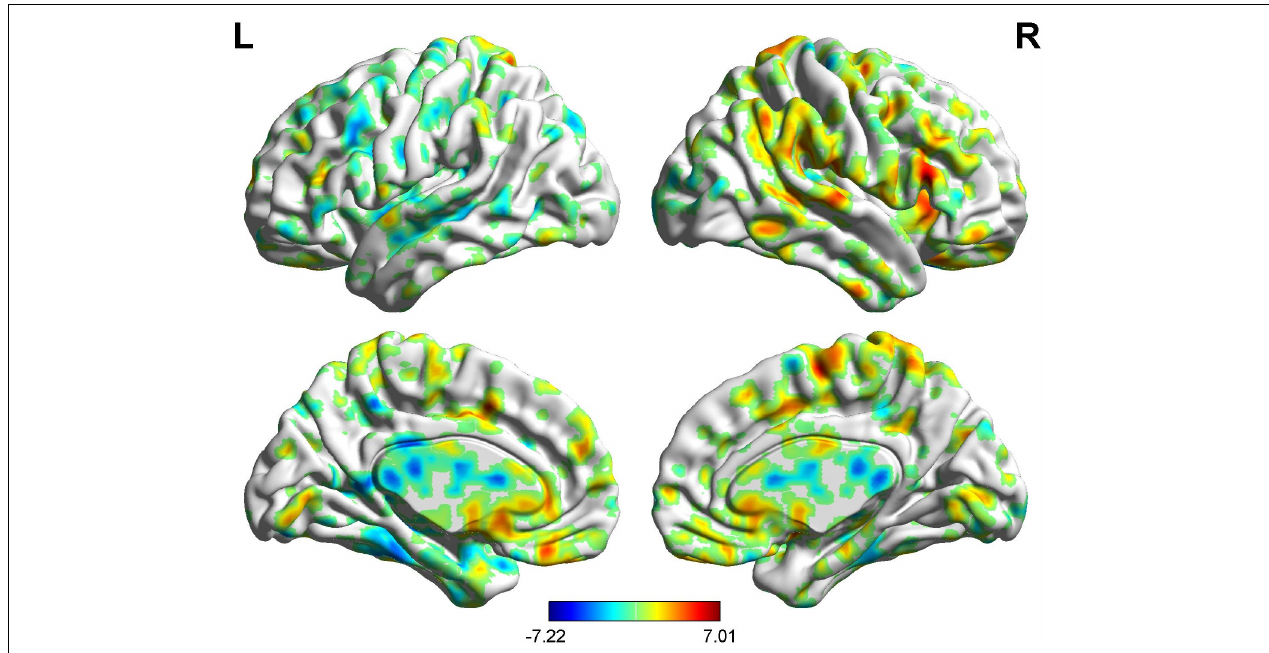
FIGURE 8 | Brain areas showing functional connectivity with the rACC in nocebo response in male participants. Color scale represents the Z -score. Red = nocebo > pain; blue = pain > nocebo.